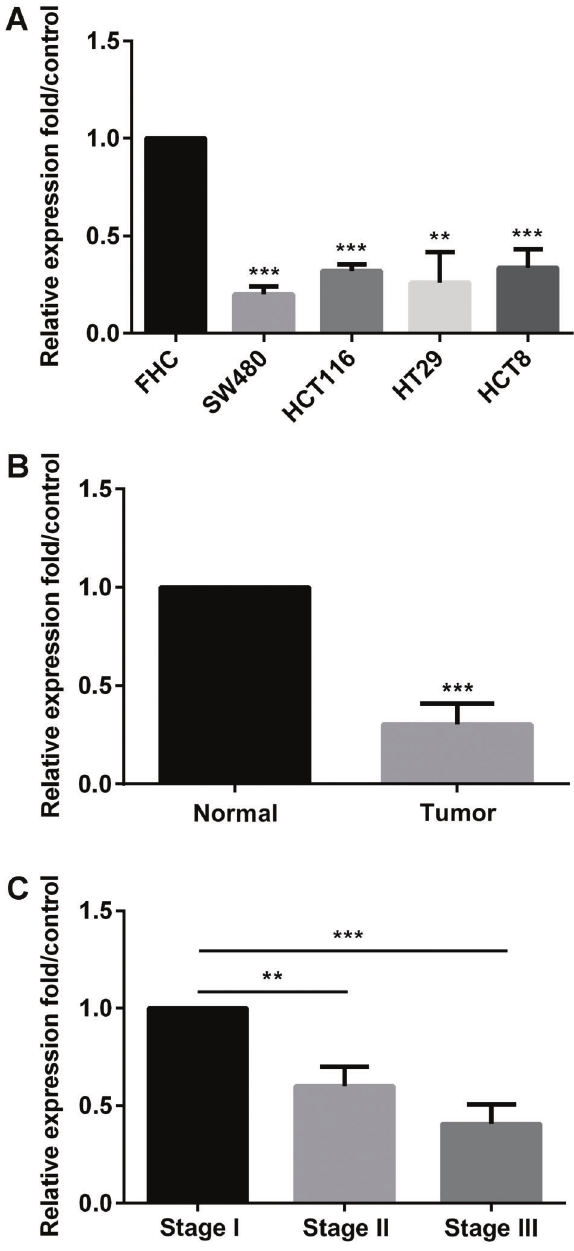
Figure 1. A and B , LINC00261 was detected in colon cancer cell lines SW480, HCT116, HT29, HCT8, and tissues. C , LINC00261 was detected in different stages. FHC: fetal human cells. Data are reported as means ± SD. **P o 0.01; ***P o 0.001